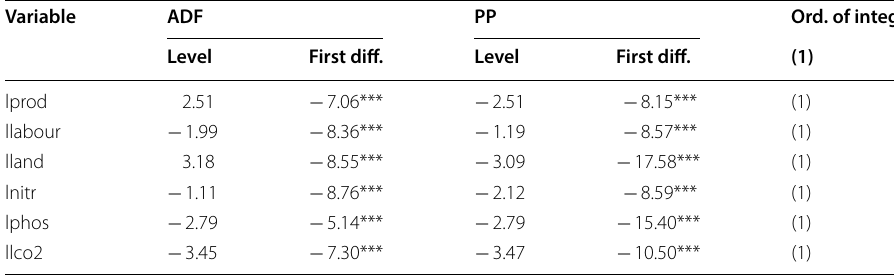
Table 3 Results of unit root tests Source : Author’s calculation Variable ADF PP Ord. of integ. First diff.